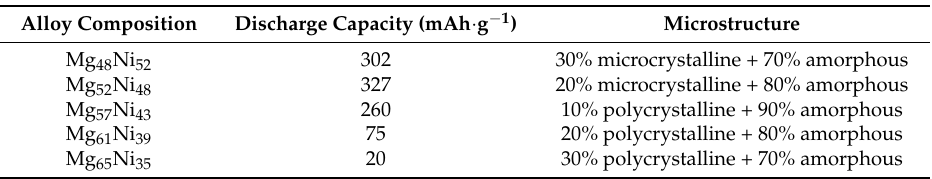
Table 2. Maximum discharge capacities of Mg-Ni binary thin films deposited on ice water-cooled nickel substrates with 20 mA · g − 1 charge and discharge current densities. Mg 52 Ni 48 (AR1) is identified as the composition with the highest discharge capacity. Microstructures and phase abundances were obtained from the X-ray diffraction (XRD) patterns in reference [50].